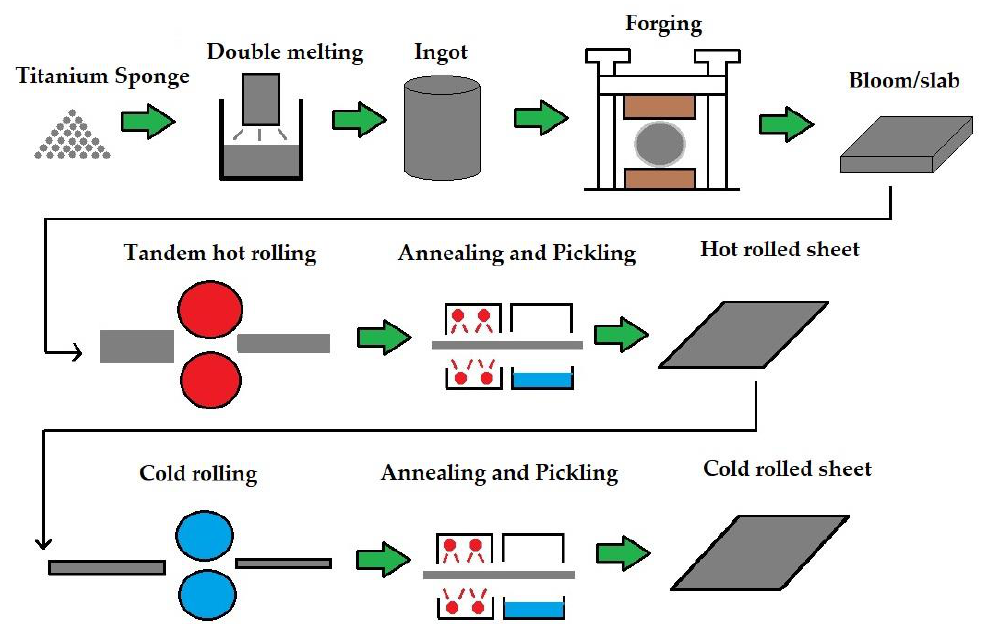
Figure 1. Titanium sheet production via the wrought process (adapted from [10]).